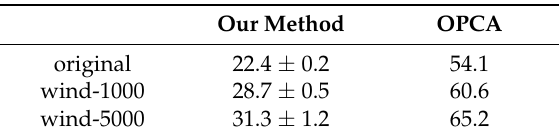
Table 3. The comparison of our method with the OPCA (Online Principal Component Analysis) method on false negative